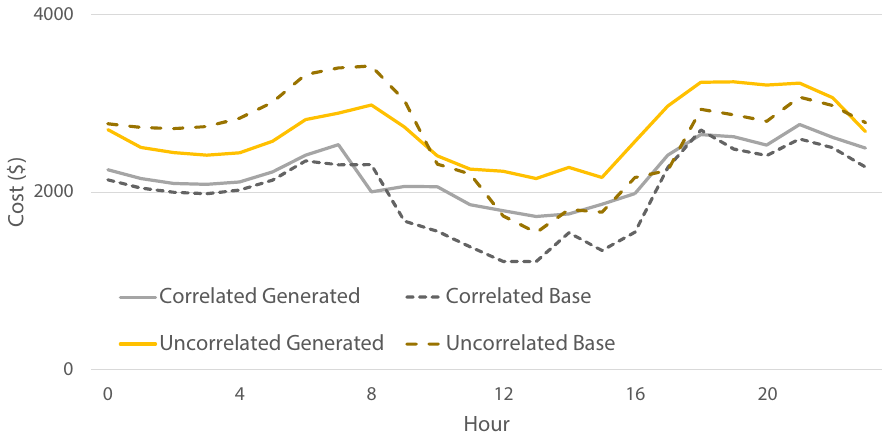
Figure 10. Winter abnormal hourly costs (ratio = 0.6).